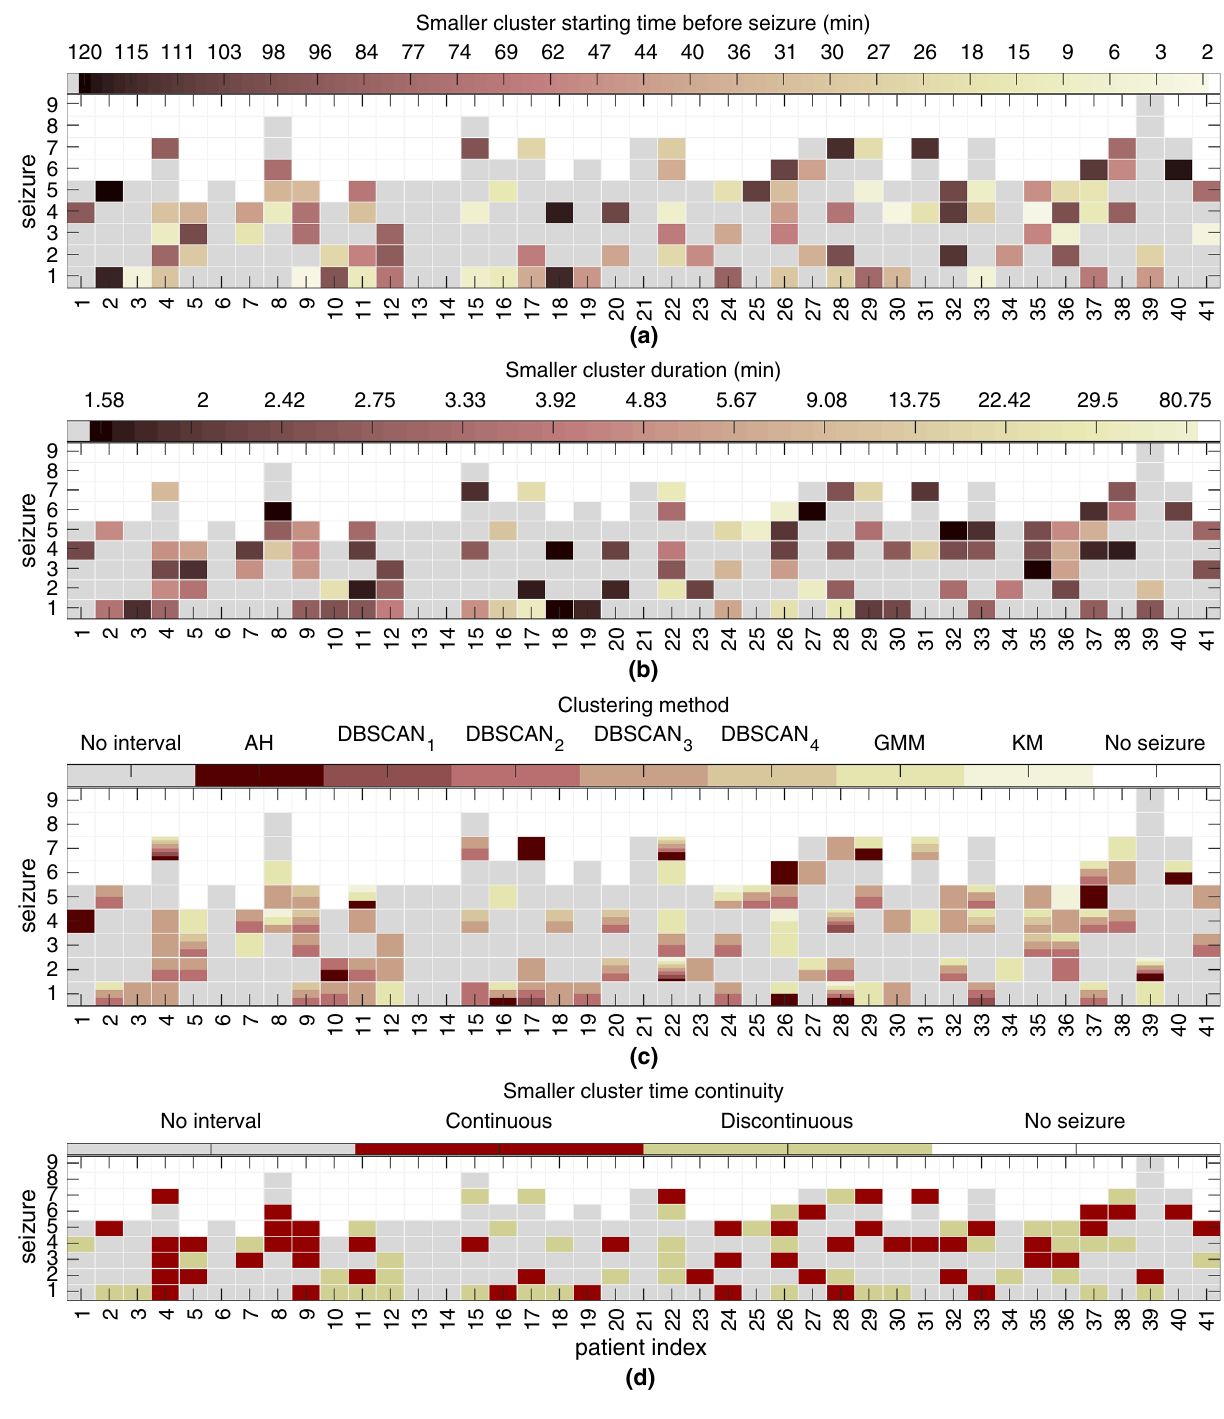
Figure 3. Results for the selection of clustering solutions based on time continuity and duration. The smaller cluster from the selected two-cluster solutions found for 97 seizures was characterized. The colours in the figure indicate ( a ) the smaller cluster start time before seizure onset (0 min); ( b ) the duration of the smaller cluster; ( c ) the clustering methods returning the clustering solutions; and ( d ) the continuity over time of the smaller cluster (54% were continuous clustering solutions). See the colour scale for each subfigure. The x-axis and y-axis in all plots contains the patient and seizure indexes, respectively. As an example, the clustering solution accepted for seizure 1 of patient 24 was returned by DBSCAN 2 and DBSCAN 3 and comprises a continuous smaller cluster that starts 84 min before seizure onset and lasts for 5.67